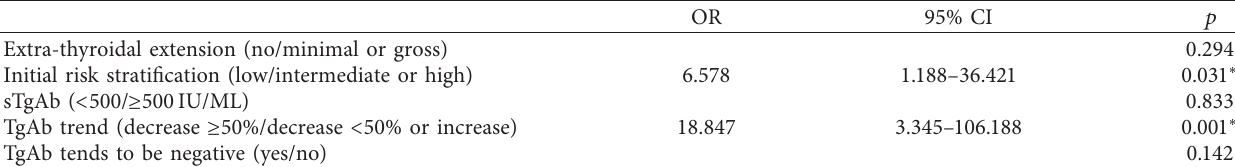
Table 3: Multivariate logistic regression analysis for clinicopathologic factors associated with responses to therapy.